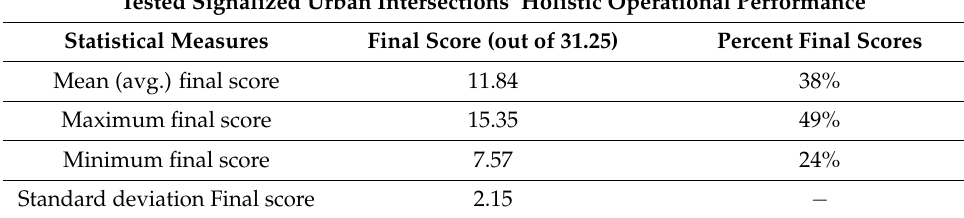
Table 4. UAE signalized urban intersections’ score on